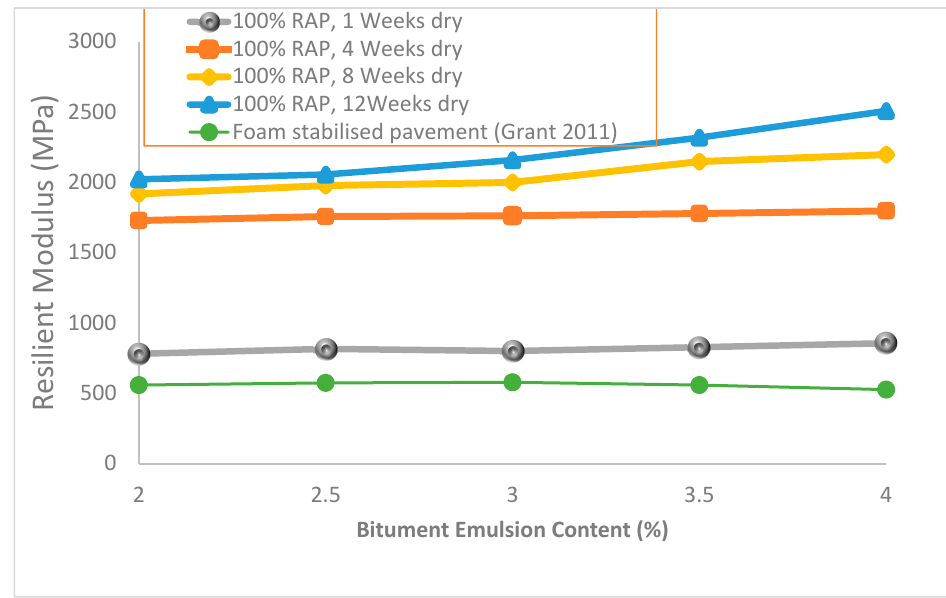
Figure 6. Resilient moduli of different asphalt mixtures.